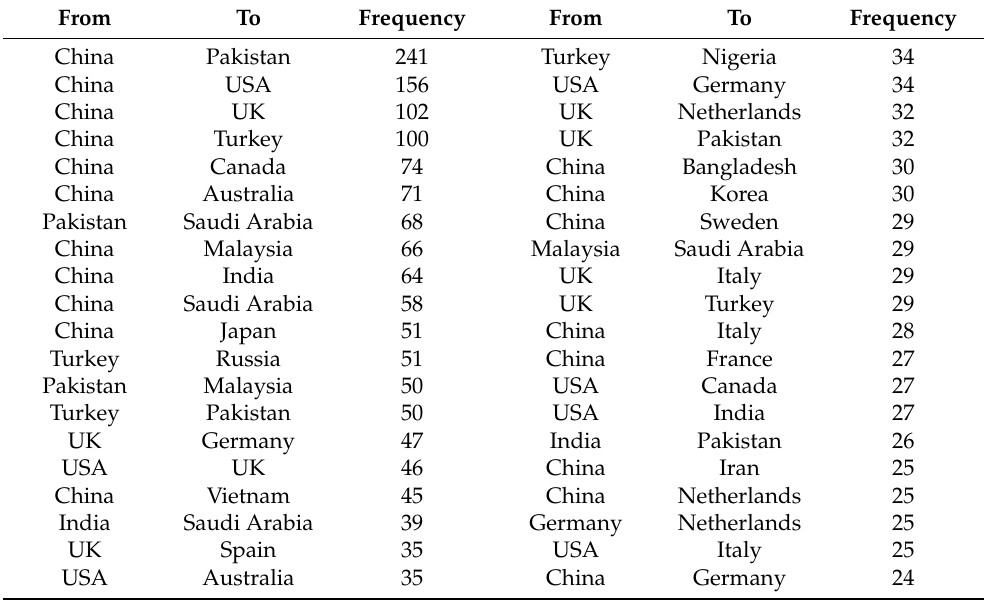
Source: own elaboration.